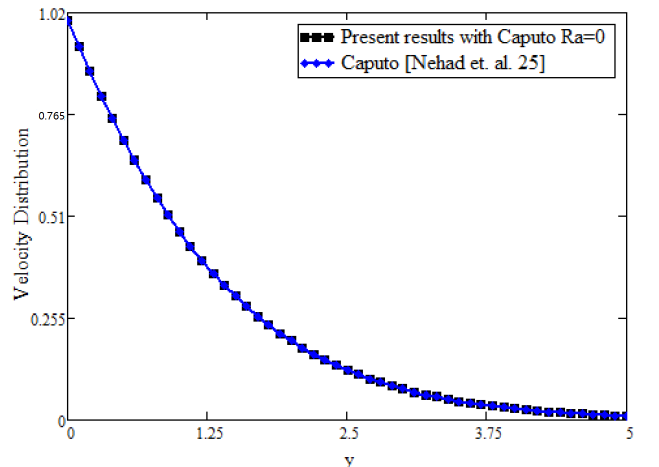
Figure 9. Comparison between present Results in the absence of bioconvection and Nehad el al. [25].